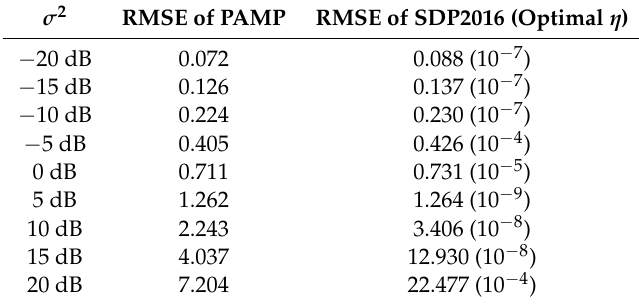
Table 1. RMSE comparison (in meter) and penalty factor selection under different σ 2 for the near-field case in scenario 1. σ 2 RMSE of PAMP RMSE of SDP2016 (Optimal η